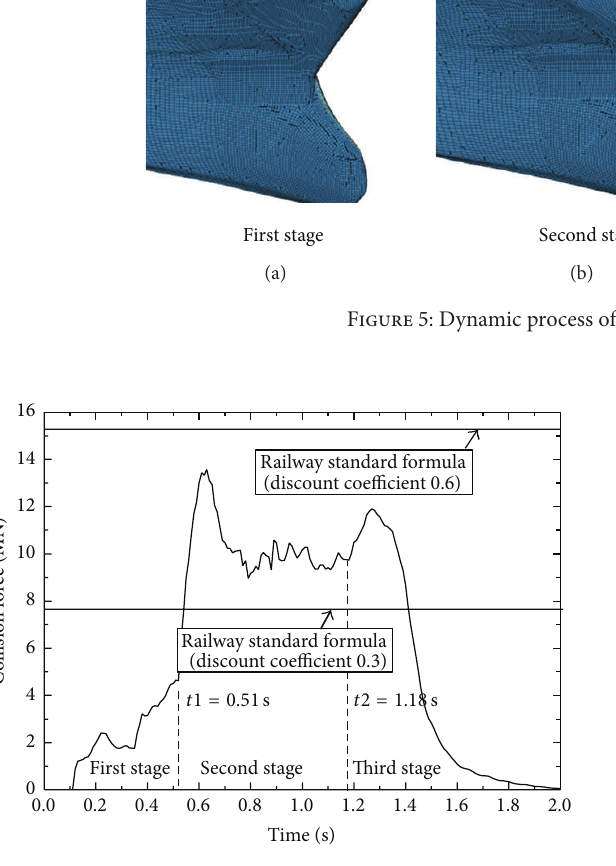
Figure 6: Time history curve of the collision force. The motor moves with a speed of 80 km/h. In the down direction (the train moves from the right to the left), when − 385 m, the collision happens as the head of the train 𝑋 2 is arrives at point D in Figure 10. The calculation condition is explained in more detail in Table 2. The corresponding lateral